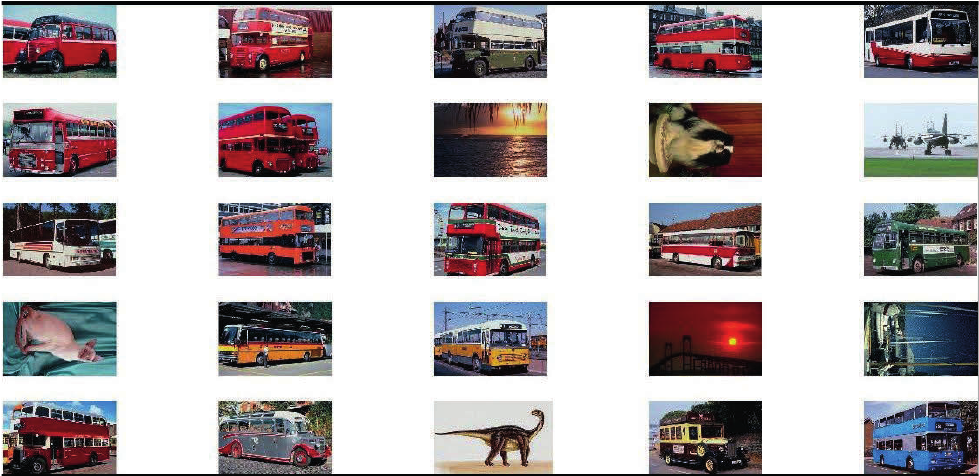
Fig. 23. Bus images retrieved at the first stage of Framework-1 (EHDKM).